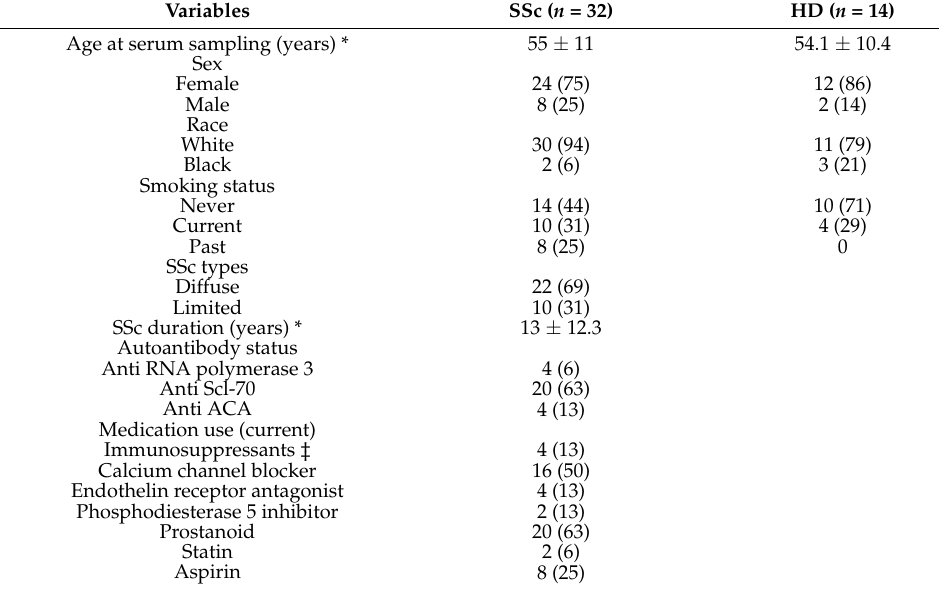
Table 1. Patient demographics and clinical